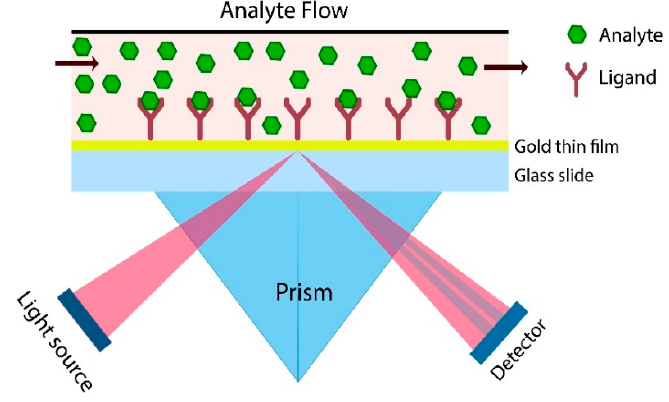
Figure 3. Direct label free detection.